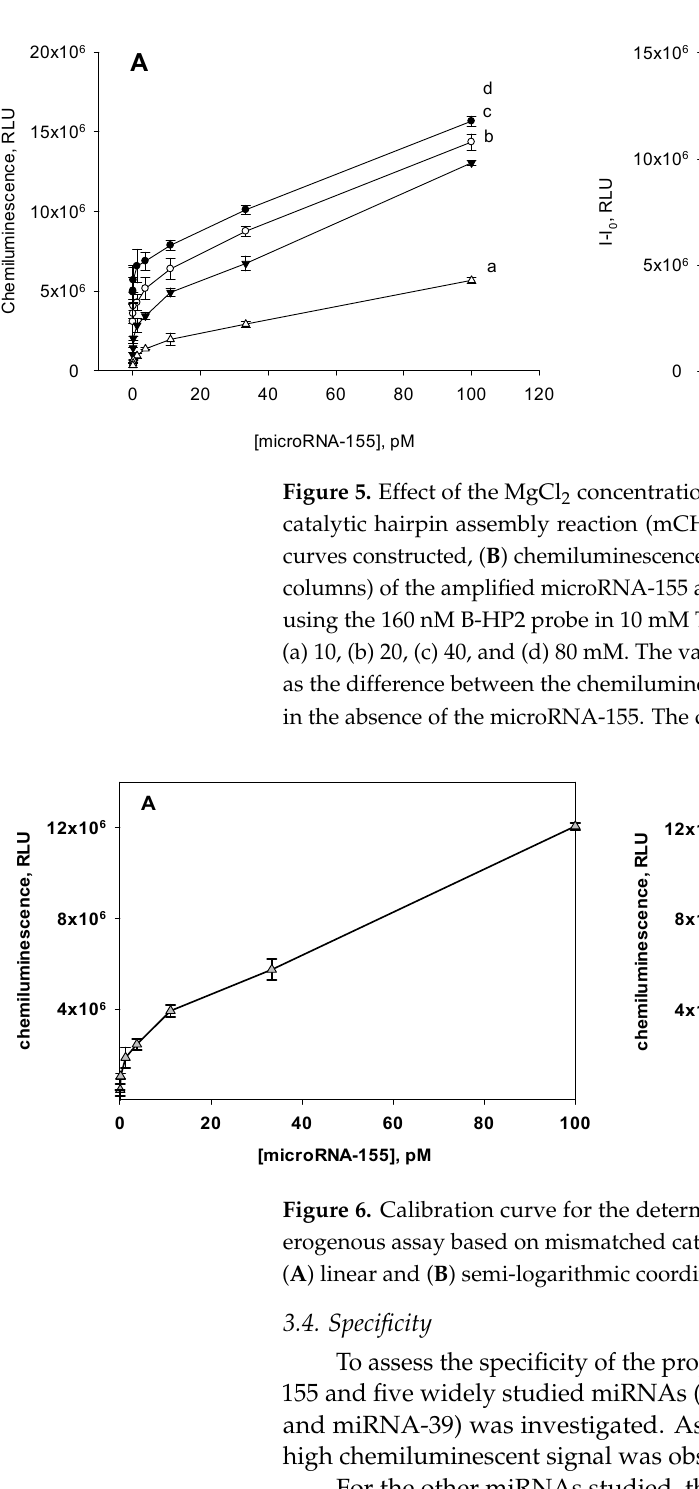
Figure 6. Calibration curve for the determination of microRNA-155 by the chemiluminescent het- erogenous assay based on mismatched catalytic hairpin assembly amplification (n = 6) presented in ( A ) linear and ( B ) semi-logarithmic coordinates.